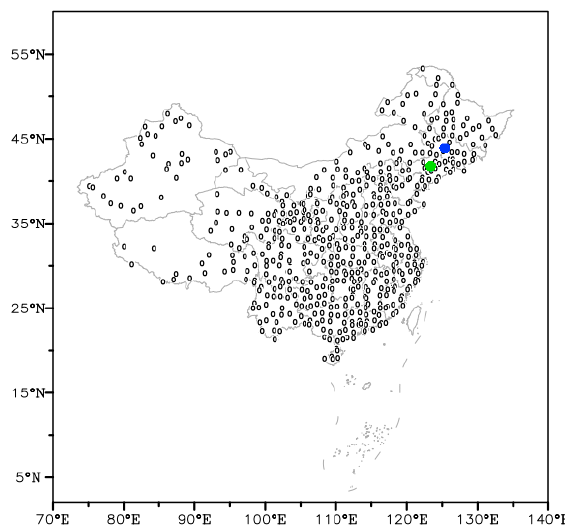
Figure 1. Station distribution in China. Stations with consecutive missing data for more than 2 days are excluded and a total of 555 stations are selected. The green point denotes Shenyang, the provincial capital of the Liaoning Province and the blue point represents Changchun, the provincial capital of the Jilin Province.